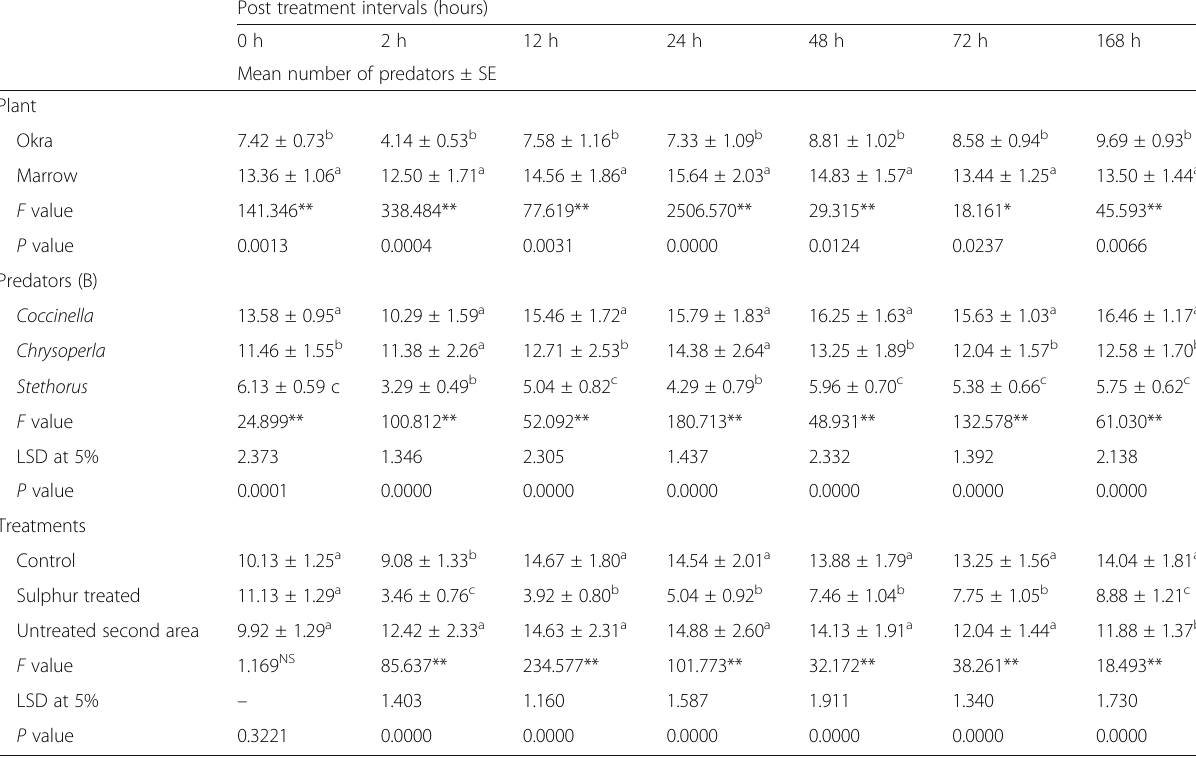
Table 1 Mean numbers of the abundance of the tested adult predators related to three examined